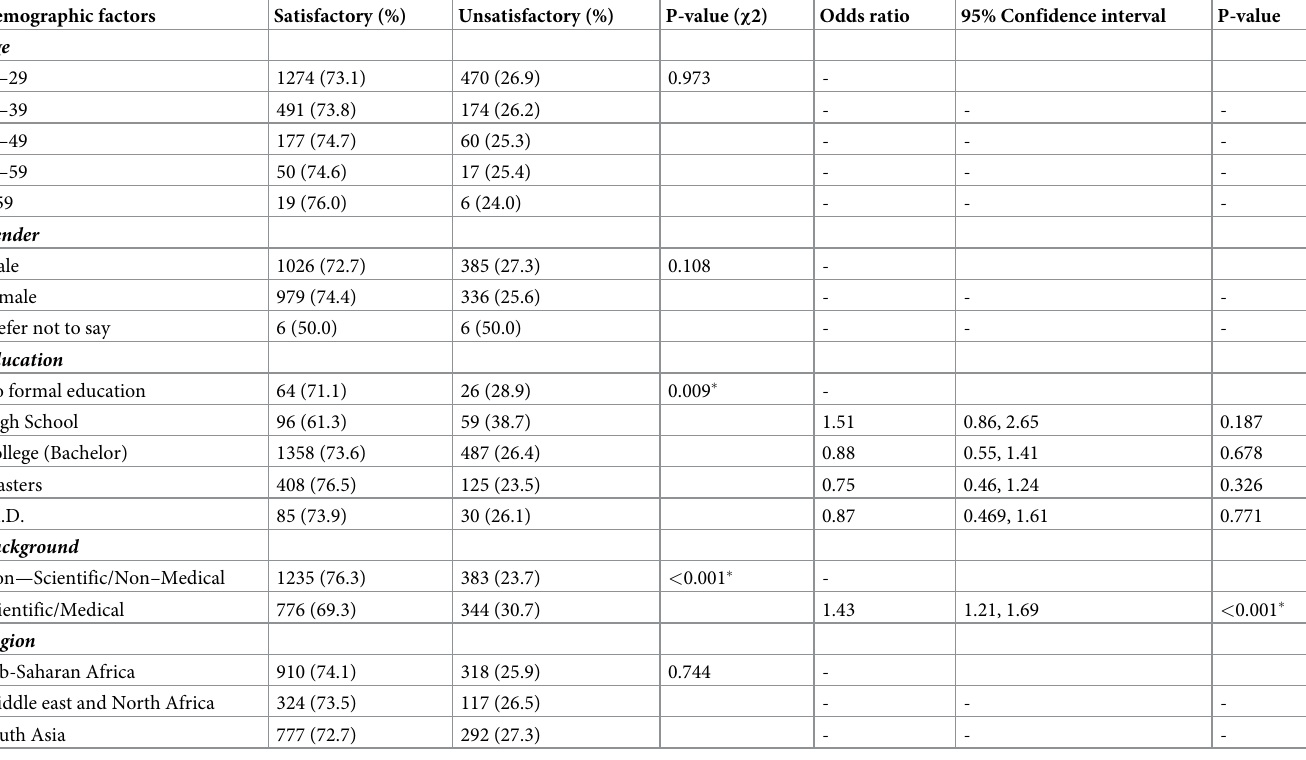
χ 2—Chi square λ - excluded from the multivariable logistic regression analysis � —significant at p <